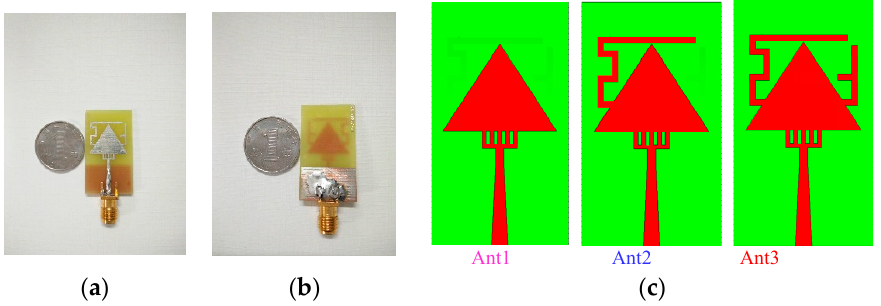
Figure 3. Fabricated photograph and design steps for the proposed antenna. ( a ) Top view, ( b ) bottom view, and ( c ) design steps for the proposed antenna used in HFSS software.